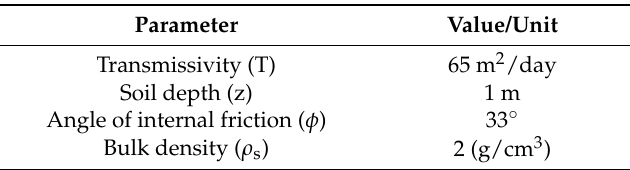
Table 2. Soil parameter values used in this